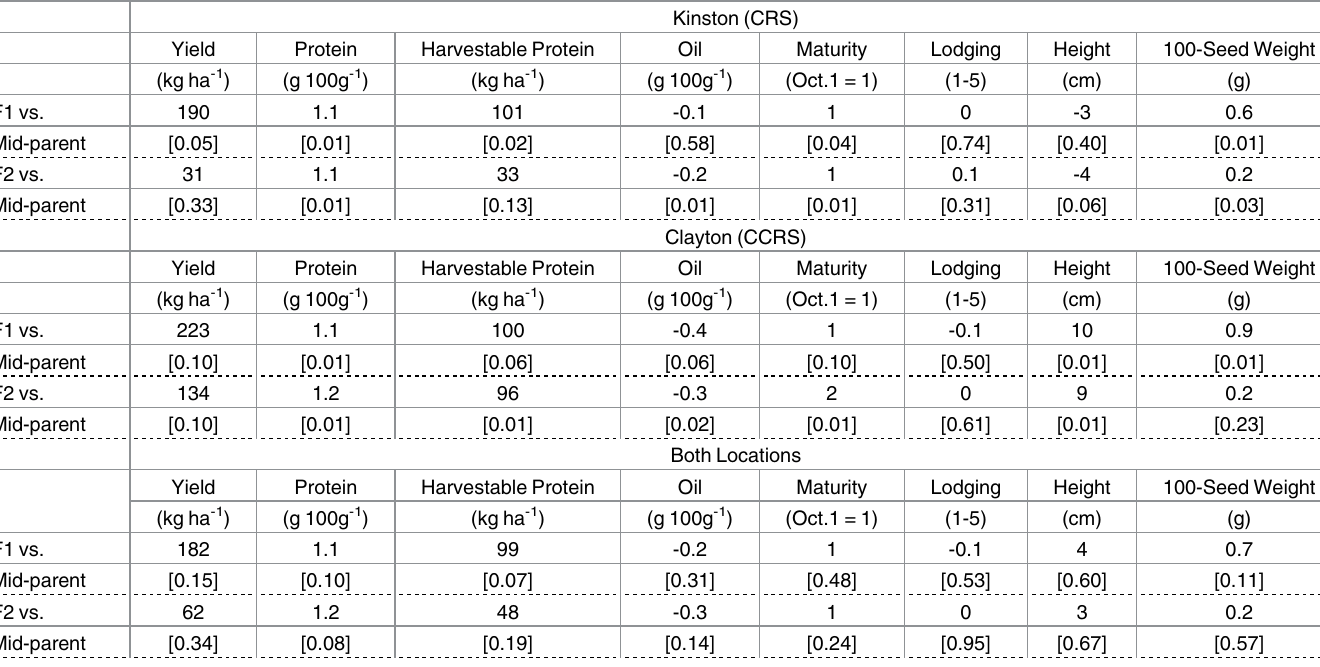
Table 3. Contrast table for agronomic data.